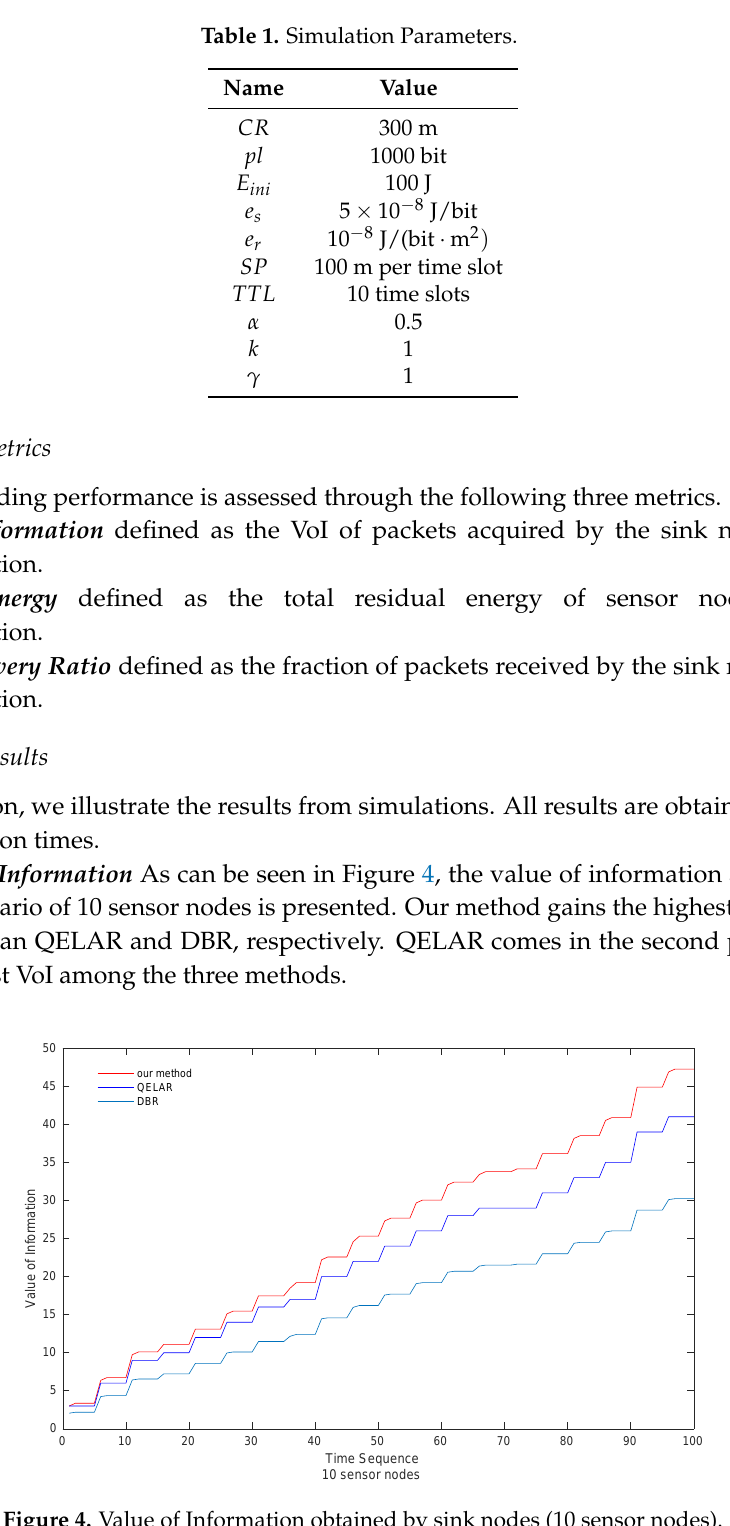
Figure 4. Value of Information obtained by sink nodes (10 sensor